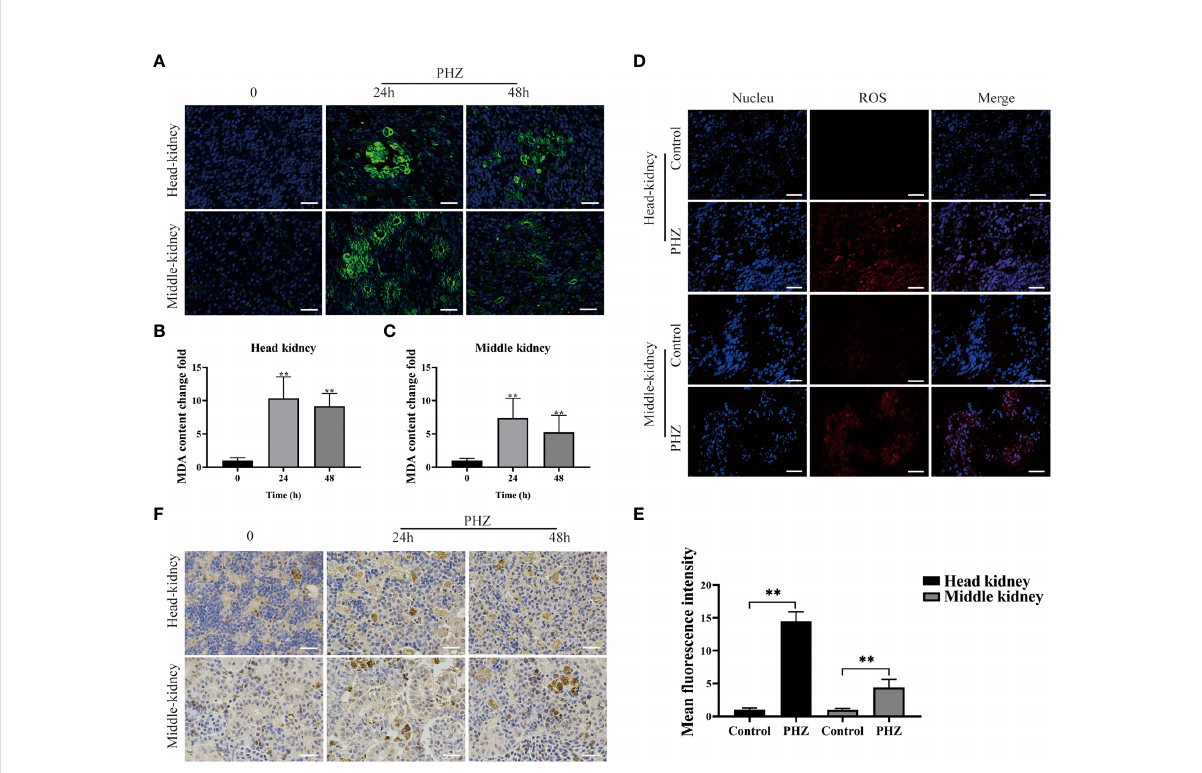
FIGURE 2 PHZ-induced hemolysis increased the generation of ROS and caused tissue oxidative damage. (A) The degree of MDA immune response was detected by green display after injection of PHZ for 24 h and 48 (h) Scale bar, 20 m m. (B, C) The content of MDA levels in head kidney (B) and middle kidney (C) at 24 and 48 h after injection of PHZ. (D, E) The generation of ROS in head kidney and middle kidney (E) were measured by fl uorescence probe DHE after injection of PHZ. Scale bar, 20 m m. (F) The IHC was used to analysis the content of 4-HNE in head and middle kidney after injection of PHZ for 24 and 48 (h) Scale means 20 m m. *P < 0.05, **P < 0.01. The data were the mean values of three independent experiments, expressed as mean ±